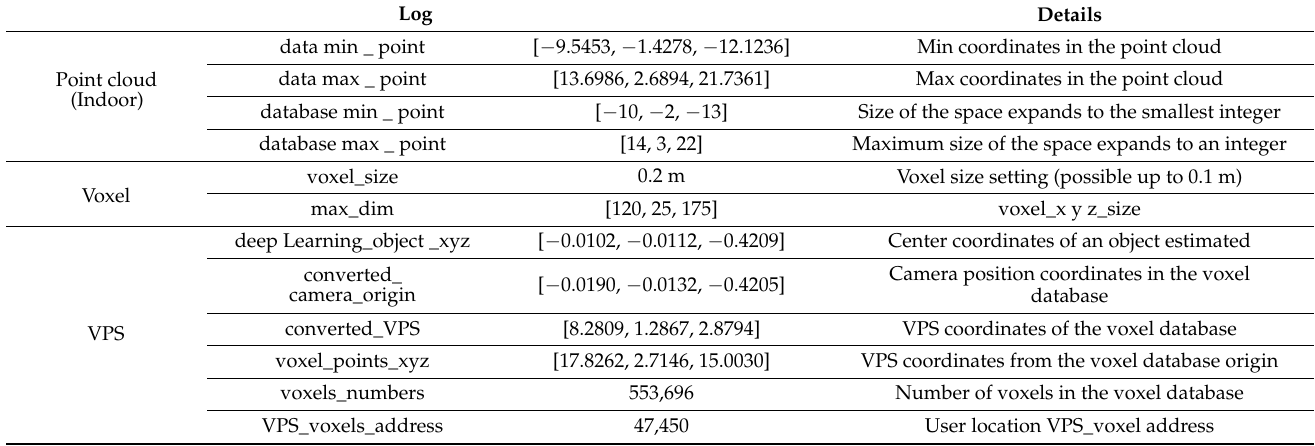
Table 4. Visual positioning system (VPS) log.